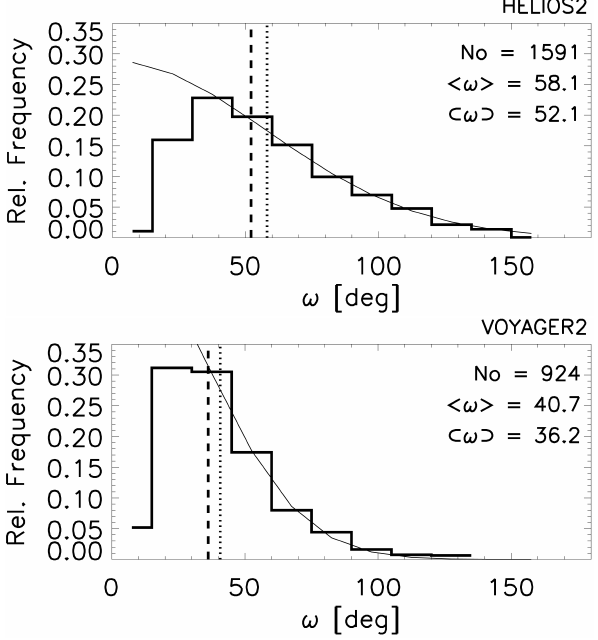
Fig. 13. Relative frequency of ω for Helios 2 (top) and Ulysses I (bottom) for RDs (solid) and TDs (dotted); the mean is given by the vertical lines.